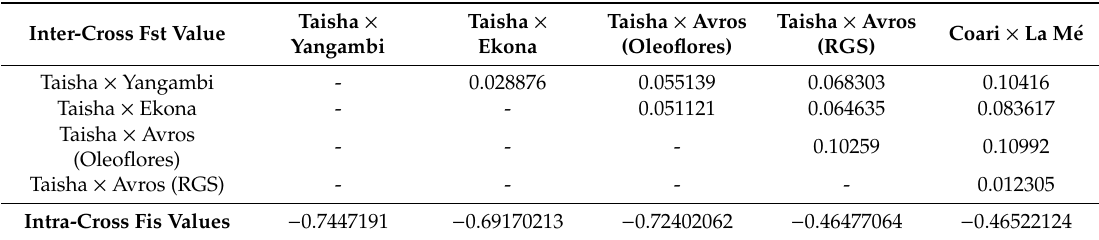
Table 2. Genetic diversity studies in terms of inter cross Fixation indices (Fst) and intra cross Inbreeding coe ffi cients